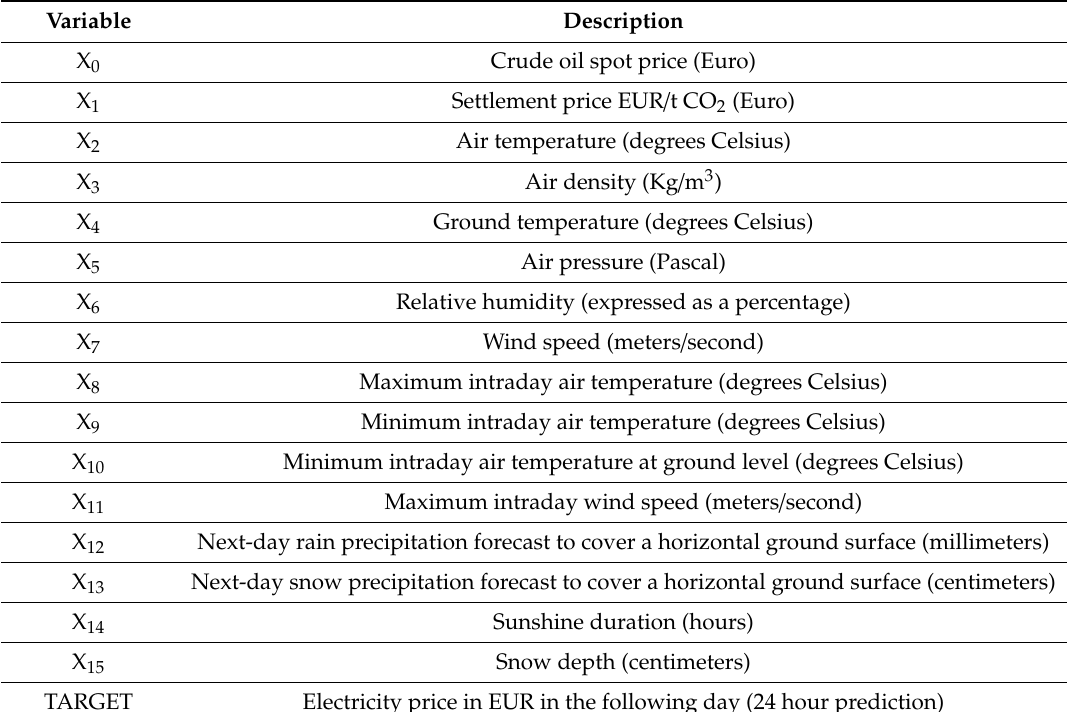
Table 1. Model variables available in the considered dataset. Observations collected on a daily basis; the task is to predict the target variable in the next 24